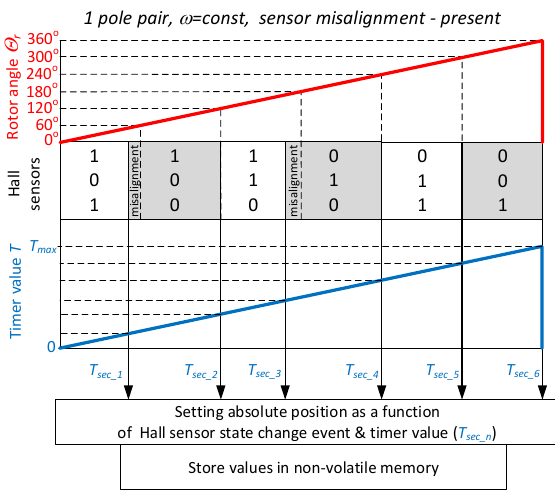
Figure 6. The proposed method of estimating the angular position of the BLDC motor based on the change in the Hall sensors ’ state for the actual arrangement of the sensors.